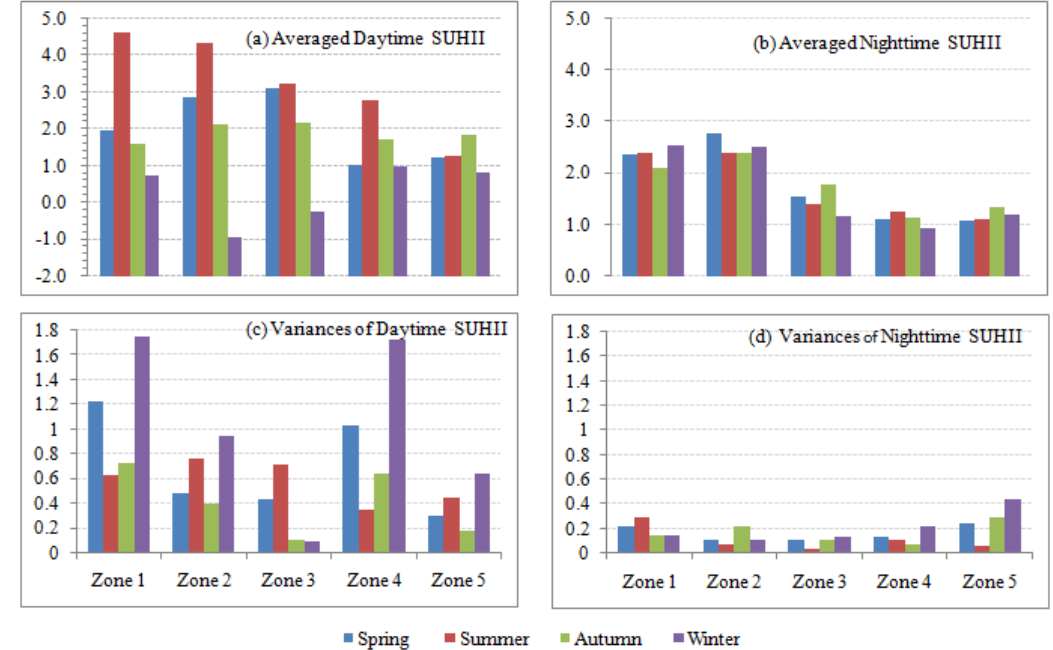
Figure 4. Seasonal averaged surface urban heat islands intensity (SUHII) values and their variances from 2003 to 2013 for different climate zones. Zone 1: severe cold region, Zone 2: cold region; Zone 3: hot summer cold winter region, Zone 4: temperate region, and Zone 5: hot summer warm winter region.